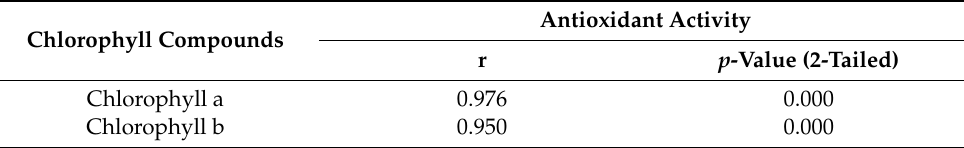
Table 3. Correlation between chlorophyll compounds and antioxidant activity in MAE of P. fruticosa